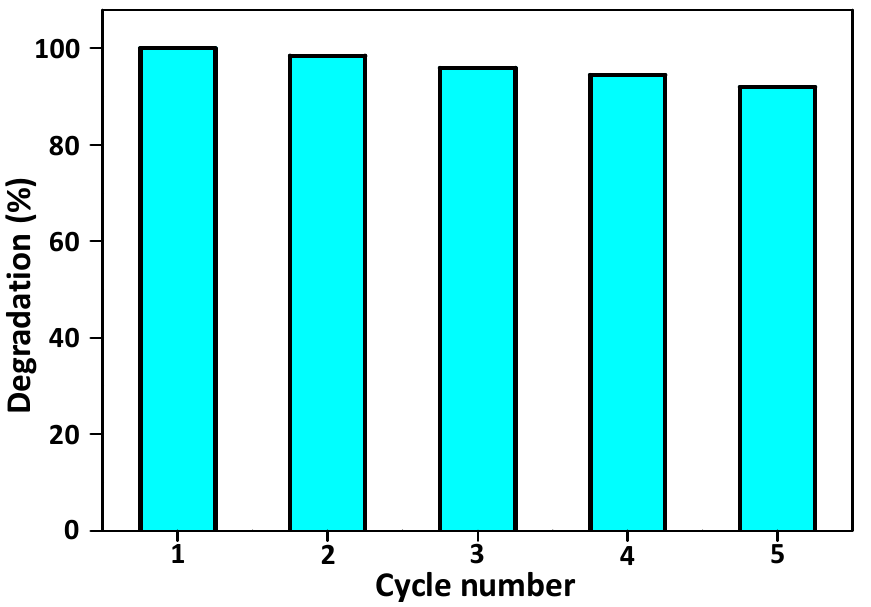
Figure 12. Degradation of MB carried out using recycling of the catalyst load (B1).